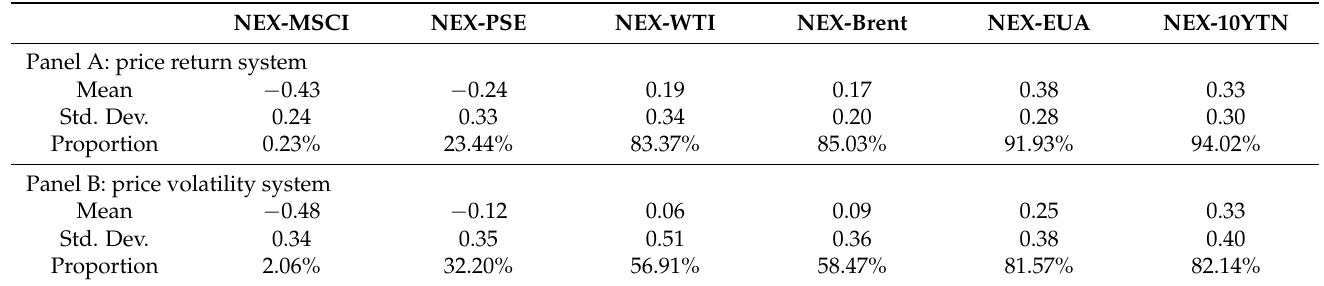
Table 4. Summary statistics of pairwise connectedness between renewable energy stocks and other